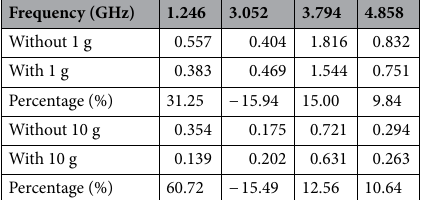
Table 8. Array metamaterial position 2.